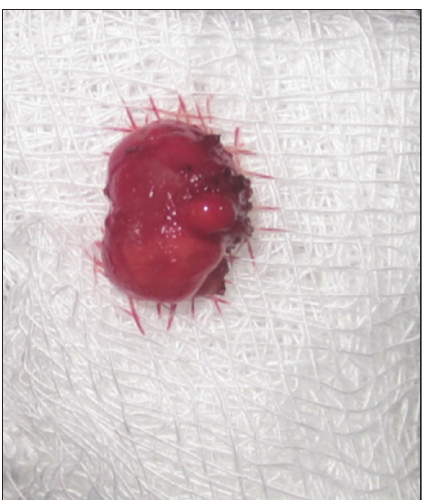
Figure 4: Excised specimen.